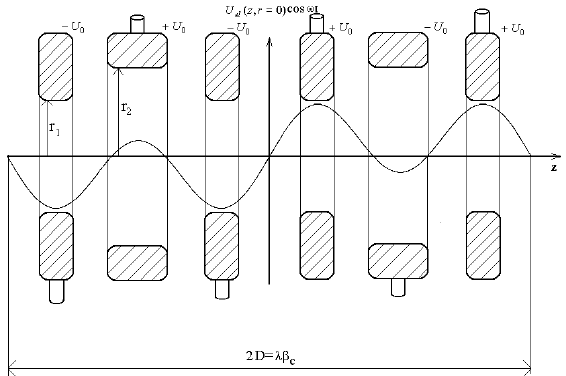
FIG. 1. Structure realization for one period of rf field potential.